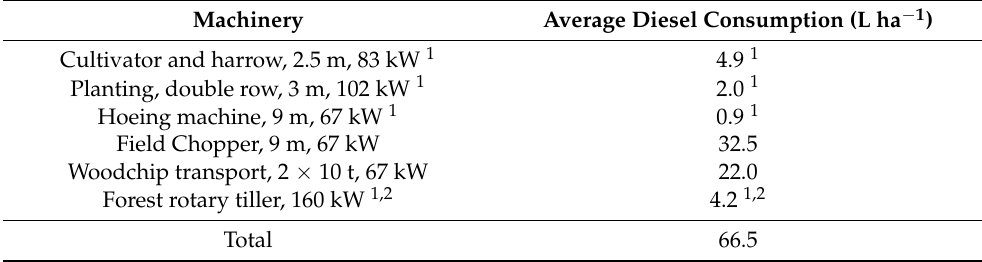
Table 2. Field operation data for cultivation and harvest of willow SRC in an agroforestry system accumulated over a 3 year period (second rotation). A farm to field distance of 5 km and a field size of 4 ha was assumed [35].